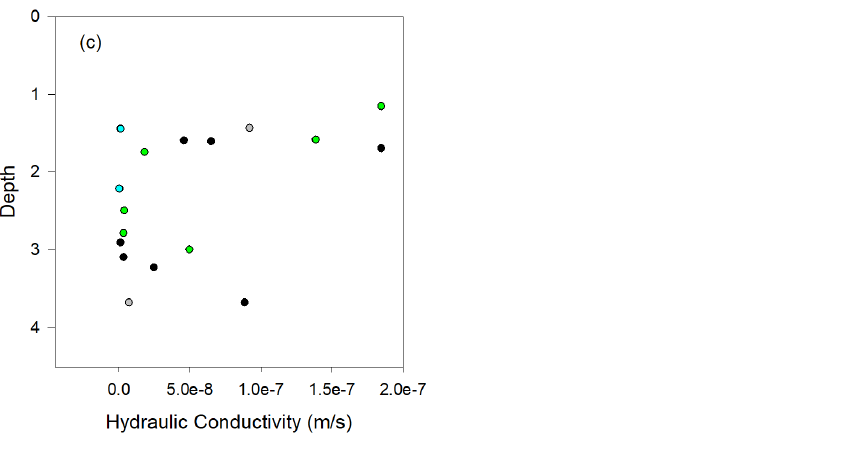
Figure 11. Plots of ( a ) nitrate and ( b ) ammonium species versus hydraulic conductivity (m · s − 1 ) and ( c ) depth versus hydraulic conductivity for ML wetlands. Terrain units are colour-coded. Error bars represent 1 standard deviation of measurements. Note that hydraulic conductivity and depth were one-time determinations.